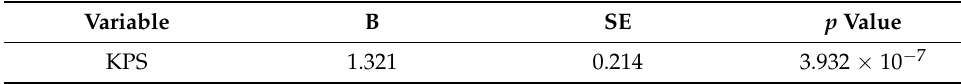
Table 6. Regression analysis of PFS2 with significant clinical characteristics.